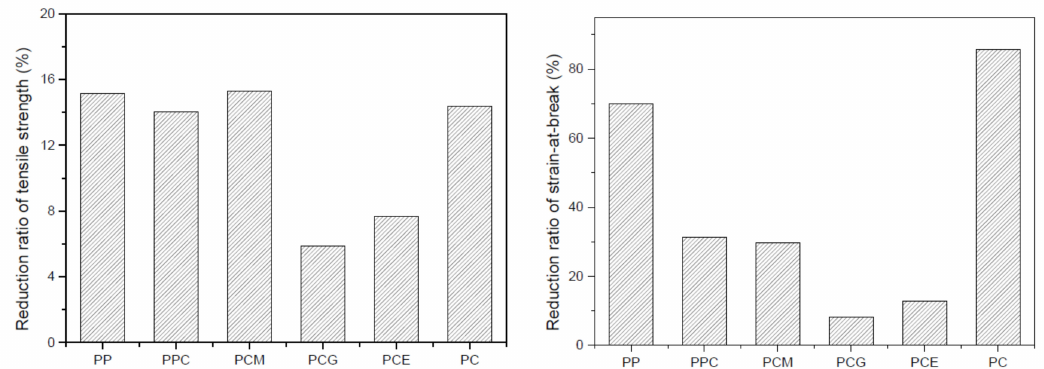
Figure 4. Reduction ratio of tensile strength ( a ) and strain-at-break ( b ) of the molded foamed PP/PC samples compared to the solid ones.